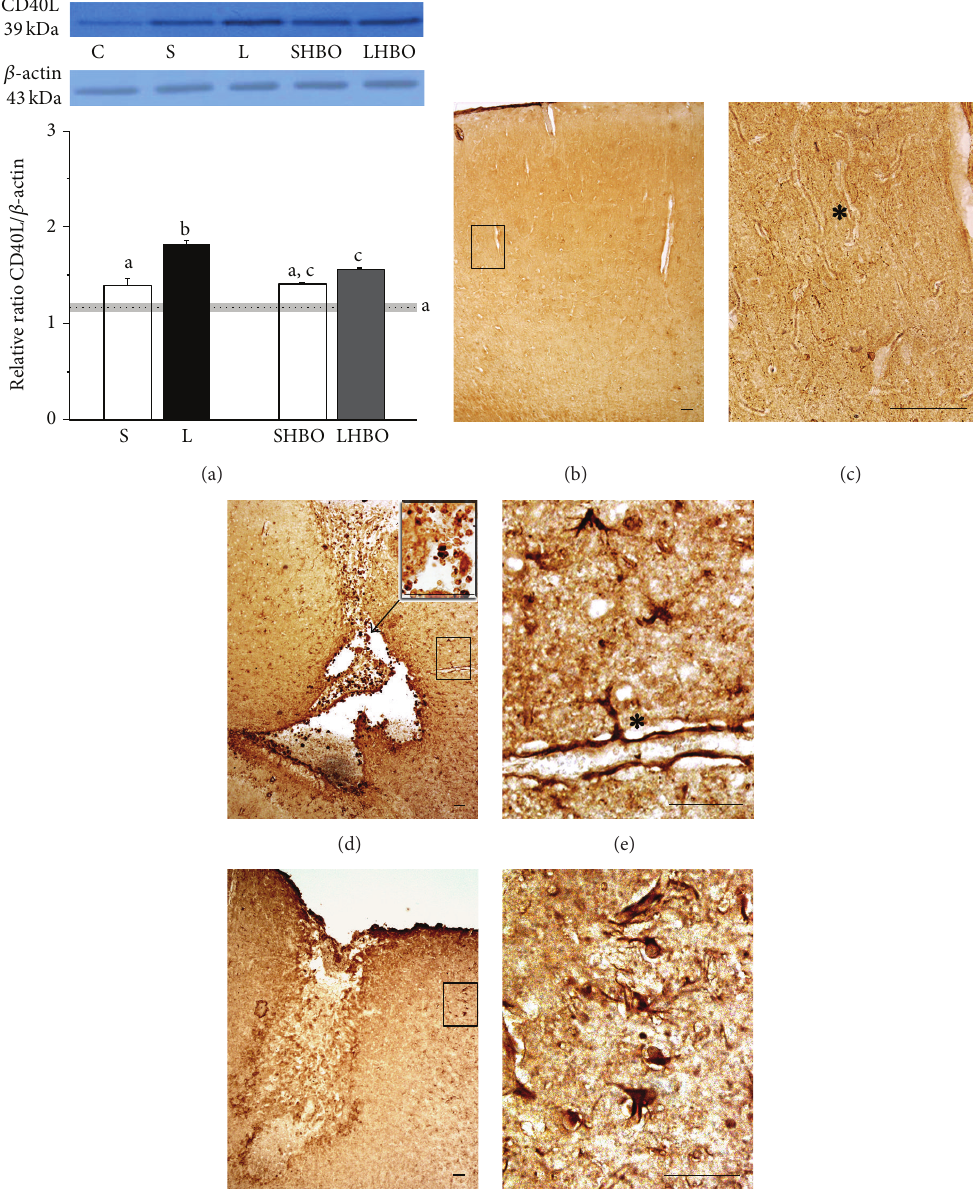
Figure 7: Repetitive HBOT downregulates CD40L expression after CSI. (a) Immunoblot analysis showed that CD40L was present as a single band with a molecular mass of about 36 kDa. After CSI expression of CD40L significantly ( 𝑃 < 0.005 ) increased in respect to intact control (C) and sham-operated animals (S). However, compared to L group in LHBO group statistically significant reduction ( 𝑃 < 0.005 ) of CD40L protein expression was observed. Bars represent mean ± SEM of CD40L protein content (relative to 𝛽 -actin). Samples are from 4 animals per each group. Dot line represents mean of CD40L mRNA or protein level ± SEM (gray area) measured in control animals. Letters indicate significance levels ( 𝑃 < 0.005 ) between lesioned (L) and intact control groups, L versus sham control (S) group, and L compared to lesioned group subjected to the HBO protocol (LHBO). The groups not sharing a common letter are statistically different. Level of significance was analyzed using Student’s 𝑡 -test. ((b) and (c)) In control cortex CD40L was localized in blood vessels ((c) asterisk). (d) At 10th day after CSI intense CD40L immunoreactivity occurred in perilesioned area: ((d), inset) in macrophages/microglia and neutrophils and (e) in protoplasmic astrocytes in close contact with endothelial cells via astrocytic end-feet (asterisk). (f) Repetitive HBOT decreased CD40L immunostaining in the injured cortex. (g) CD40L-positive astrocytes had fibrous form. Rectangles indicate where the high magnification images are taken from. Scale bar = 50 𝜇